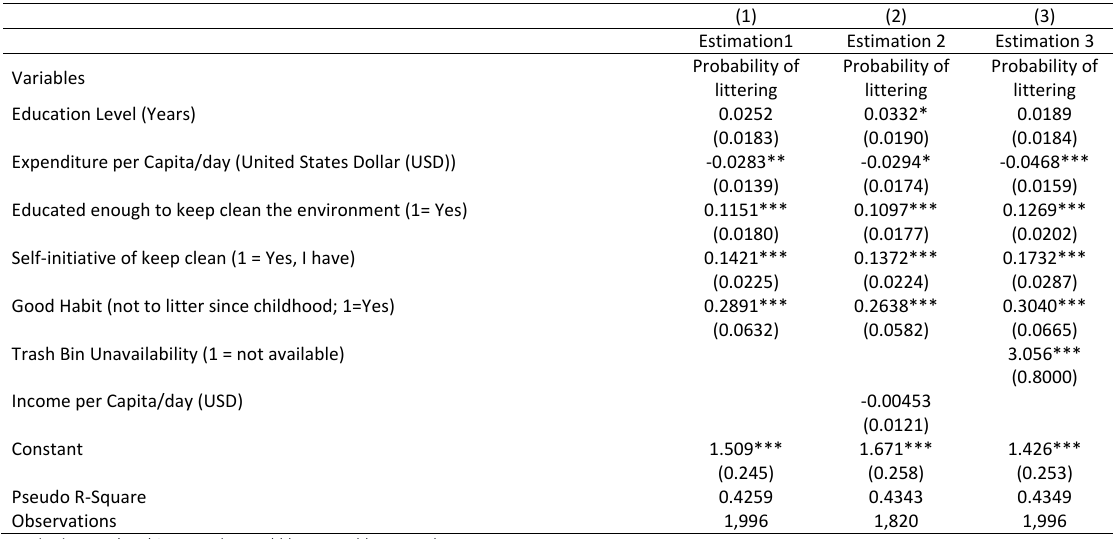
Table 2: Regression result, dummy variables are interpreted through odds ratio